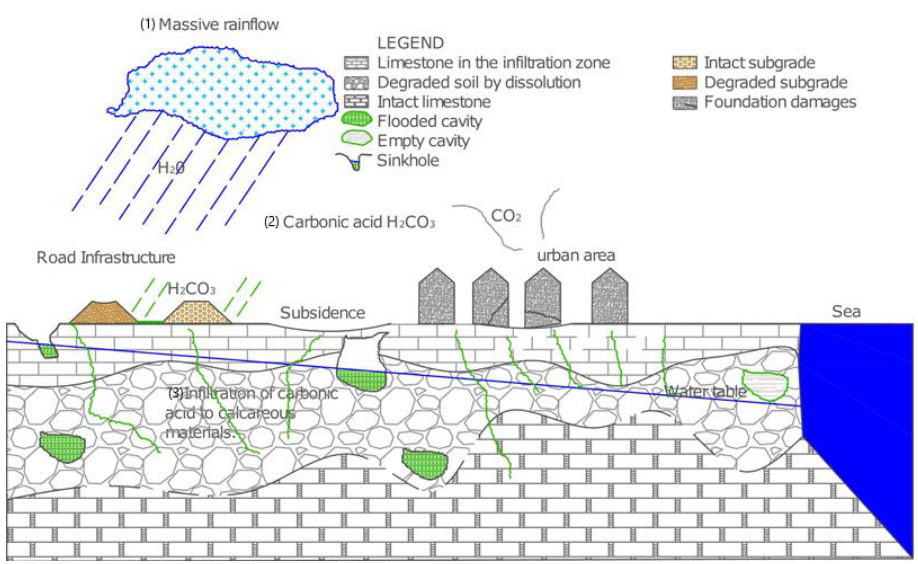
Figure 1. Scheme of the Yucatan karst landscape.